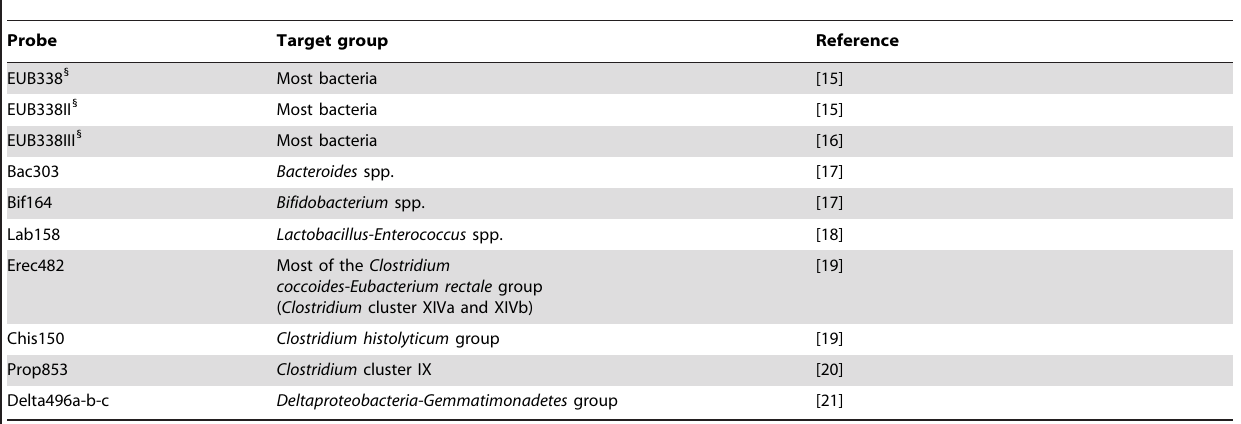
Table 1. Oligonucleotide probes used in this study for FISH